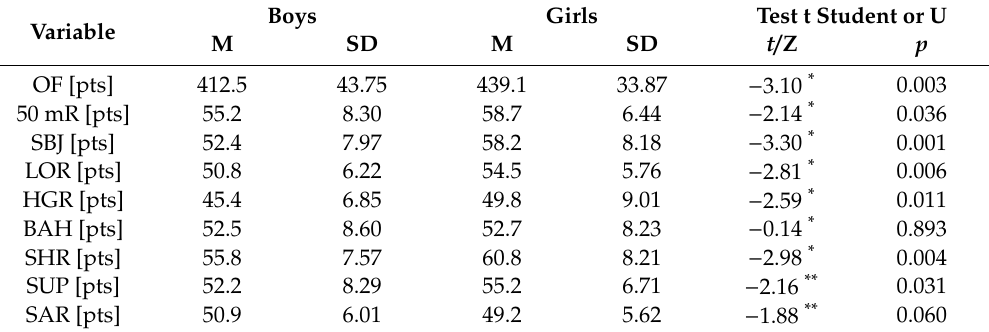
Table 2. Results of the International Physical Fitness Test (IPFT): comparison by gender.